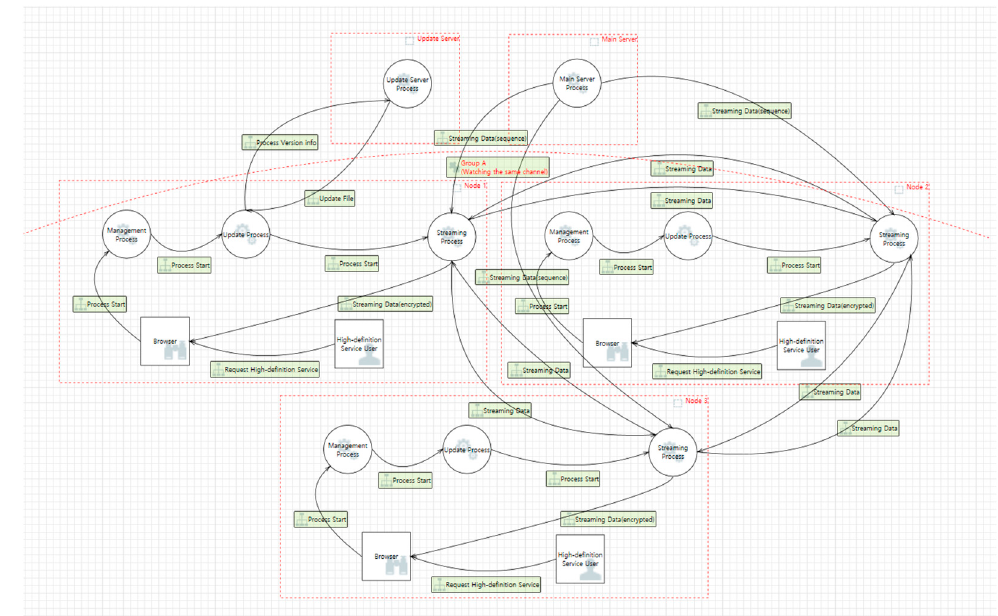
Figure 9. DFD of mesh-structure-based grid computing system.